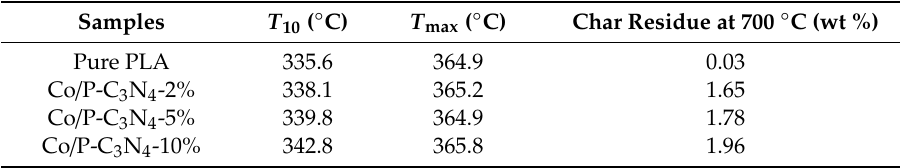
Figure 5. ( a ) TGA, and ( b ) DTG curves of PLA composites under nitrogen atmosphere. Table 3. TGA data of PLA